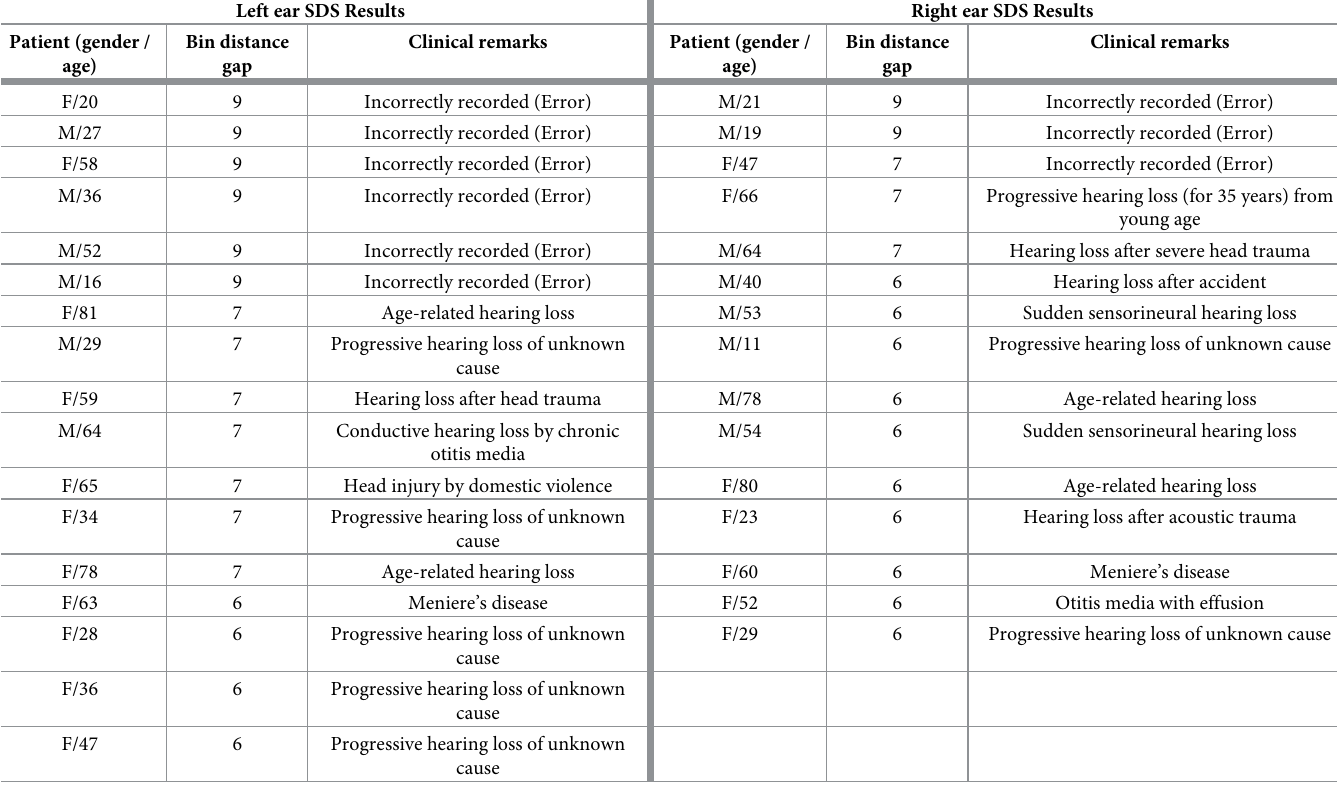
Table 6. Clinical remarks for subjects showing large bin differences ( � 6) between predicted SDS and actual SDS. Left ear SDS Results Right ear SDS Results Patient (gender / Bin distance age)